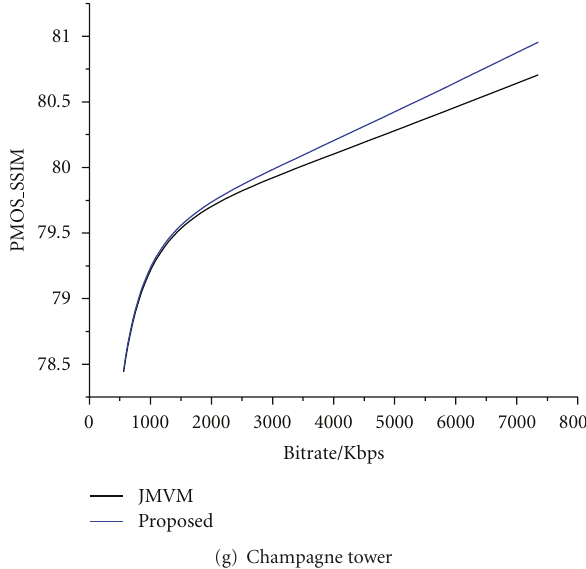
Figure 17: Rate-distortion performances comparisons between the proposed MVC and JMVM (Distortions are measured with PMOS